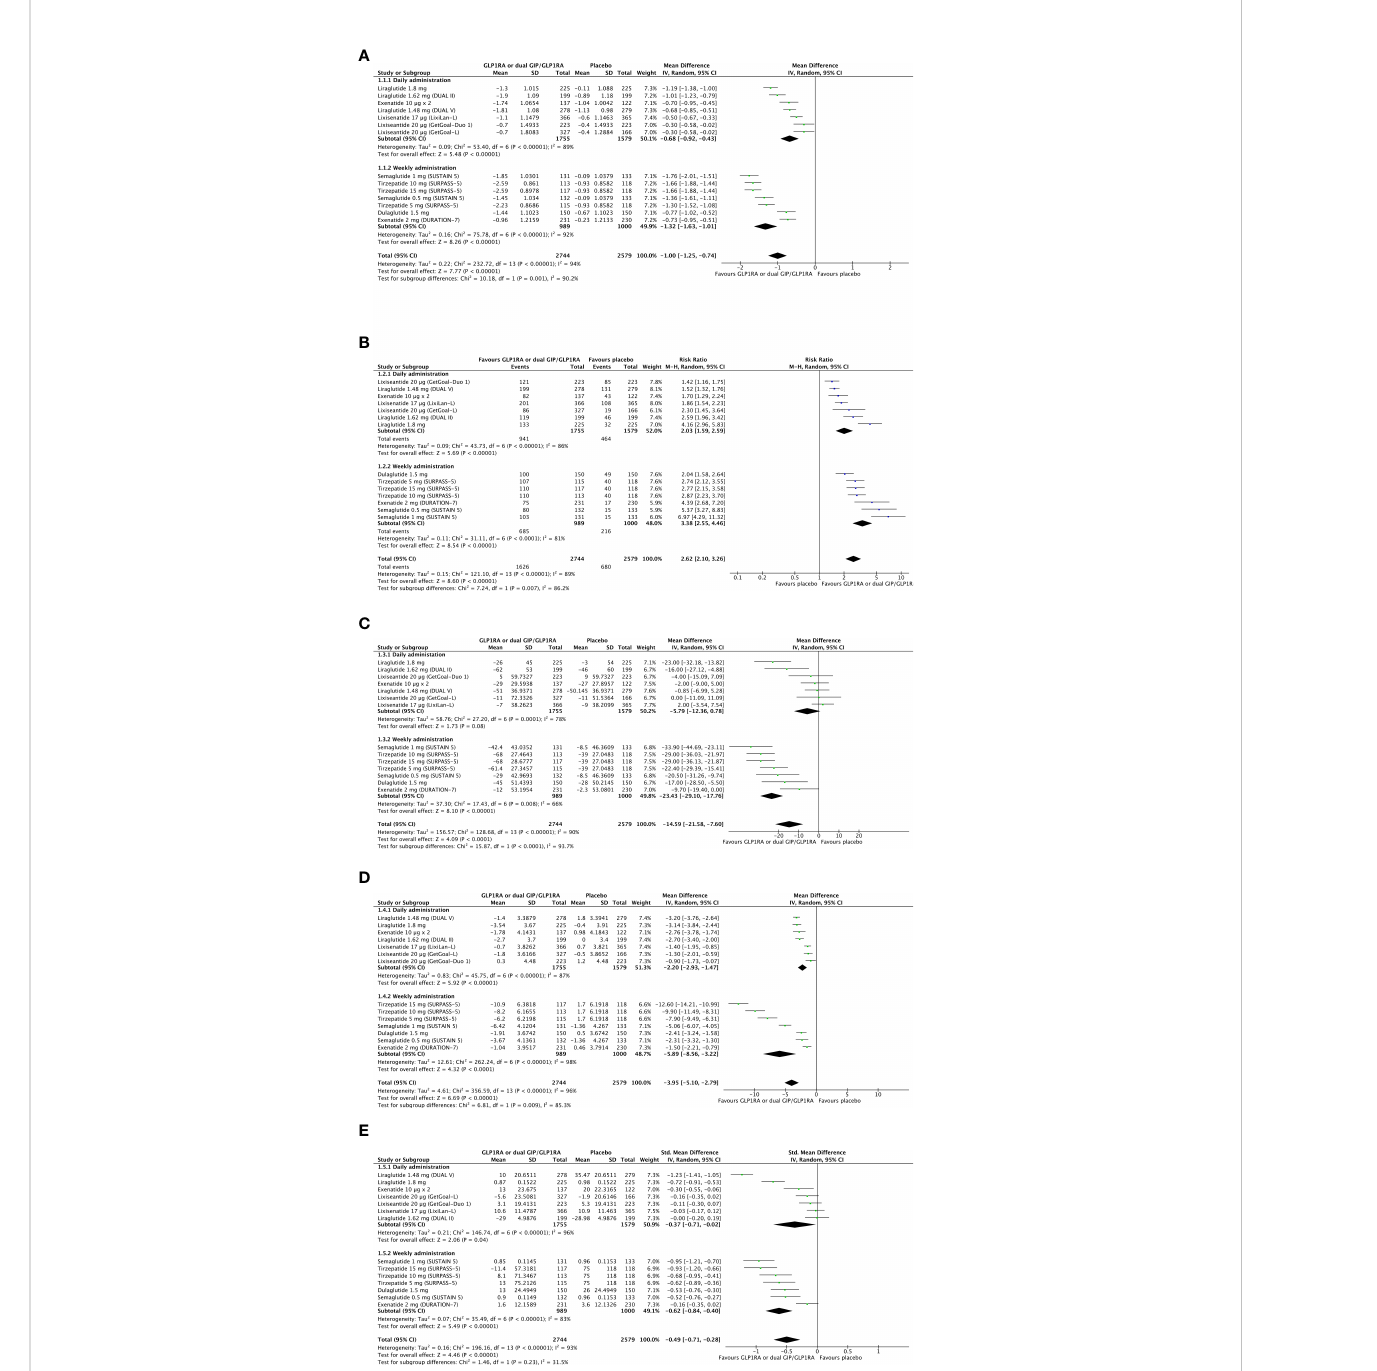
FIGURE 4 Forest plots of meta-analysis for change in HbA 1c (A) , chance of achieving optimal glucose control as HbA 1c <7% (B) , and change in fasting plasma glucose (C) from baseline to the last available follow-up (intention-to-treat analyses). Forest plot of meta-analysis for change in body weight (D) from baseline to the last available follow-up (intention-to-treat analysis). Forest plot of meta-analysis for change in the mean daily dose of basal insulin (E) from baseline to the last available follow-up (intention-to-treat